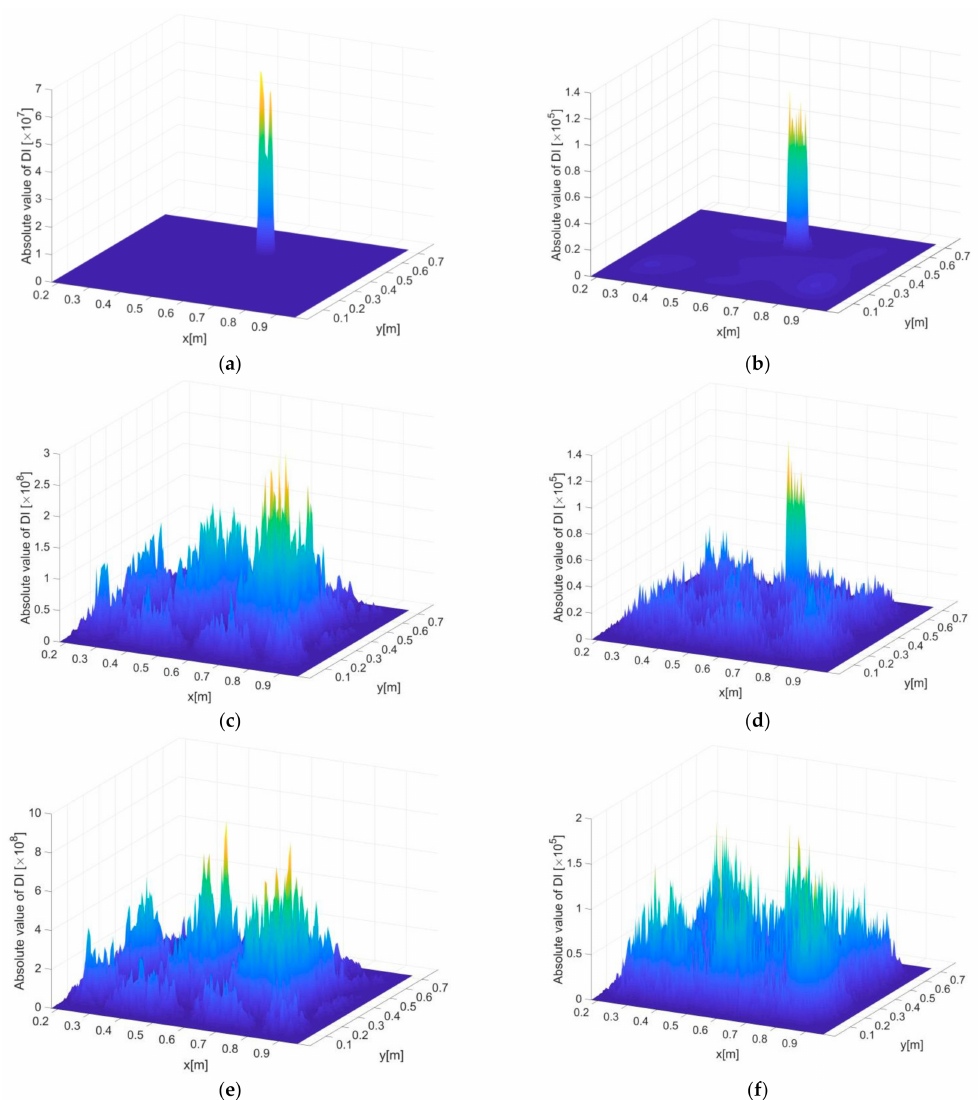
Figure 11. DI constructed based on the displacements computed by FEM and iFEM with ( a , b ) 0% ( c , d ) 1% and ( e , f ) 5% noise in level, subjected to measurement inter-distance of 6